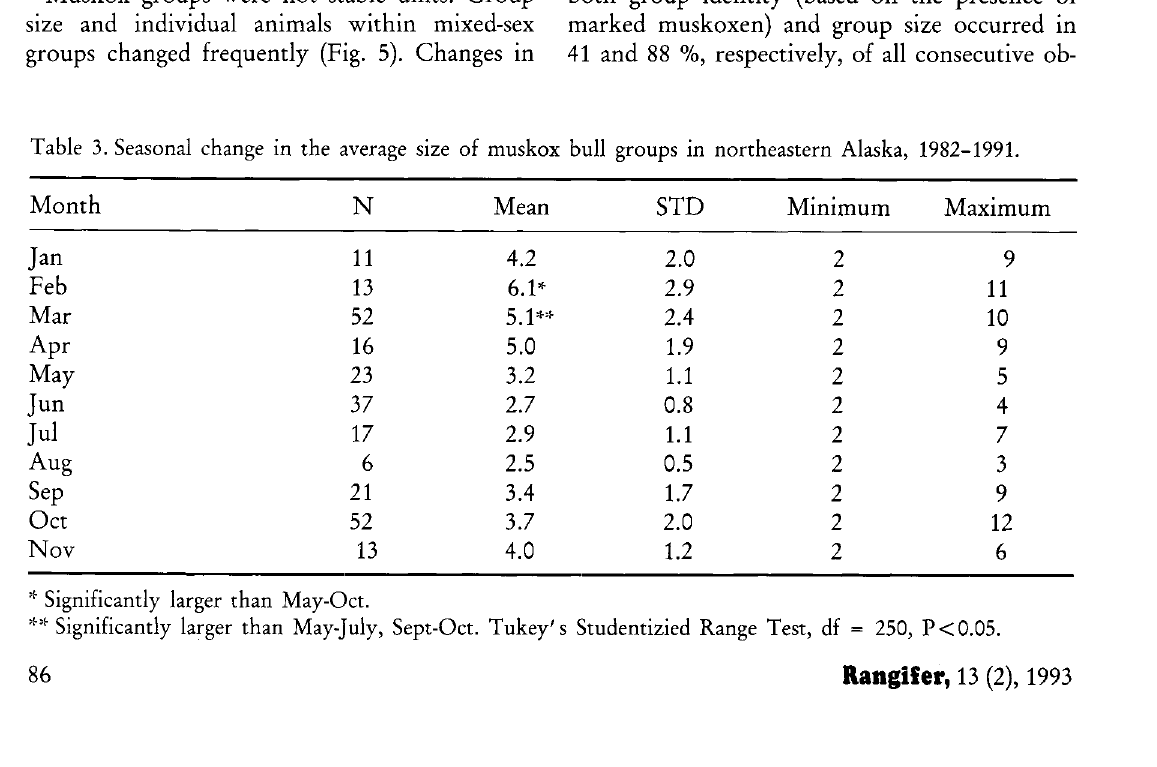
Fig. 5. An example of changes in size and group identity of groups containing marked cow muskoxen, northeastern Alaska, 1987-1990.